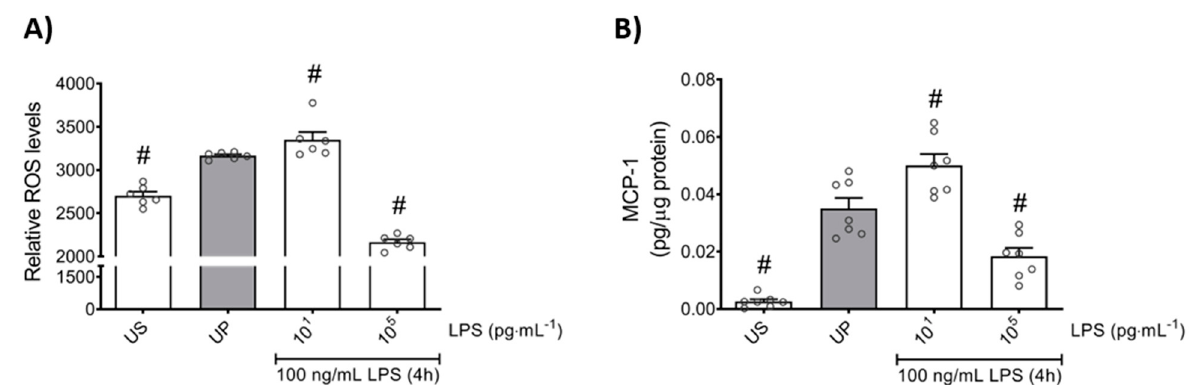
Figure 2. Effects of low- and high-dose LPS priming on ROS production and MCP-1 release in bone marrow neutrophils. Cells were primed with different doses of LPS (low-dose: 10 pg/mL; high-dose: 100 ng/mL) and re-challenged on day 2 with a fixed dose LPS (100 ng/mL) as described previously. ( A ) ROS levels (n = 6) were assessed by the 2 ′ ,7 ′ –dichlorofluorescin diacetate (DCFDA) assay, whereas the production of ( B ) MCP-1 (n = 7) was measured using ELISA (normalized to total protein concentration). Data are shown as scatter dot plots, mean + SEM, # p < 0.05, #significant differences vs. unprimed condition (UP, gray column).